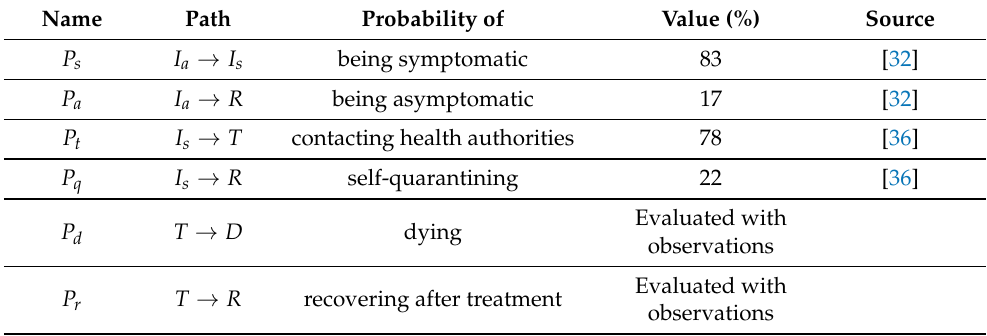
Table 1. Probabilities between compartments.